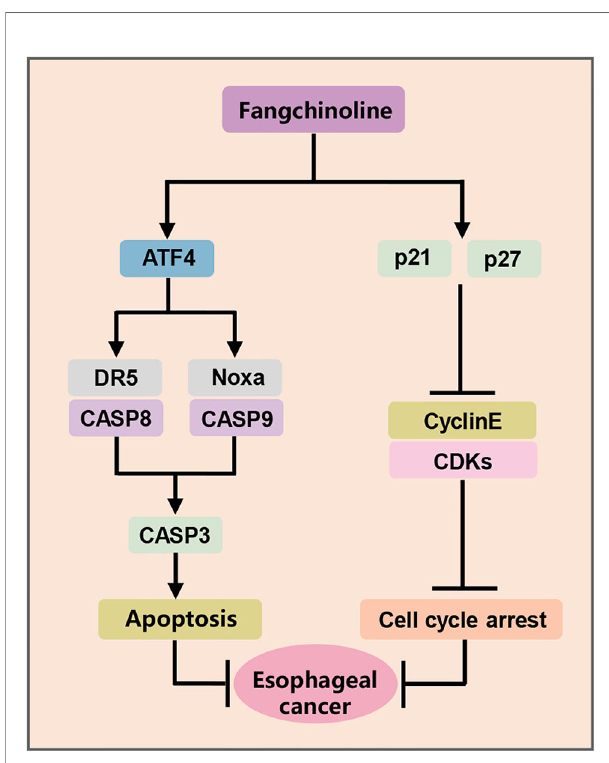
FIGURE 6 | The mechanism of FCL inhibiting the tumor growth of